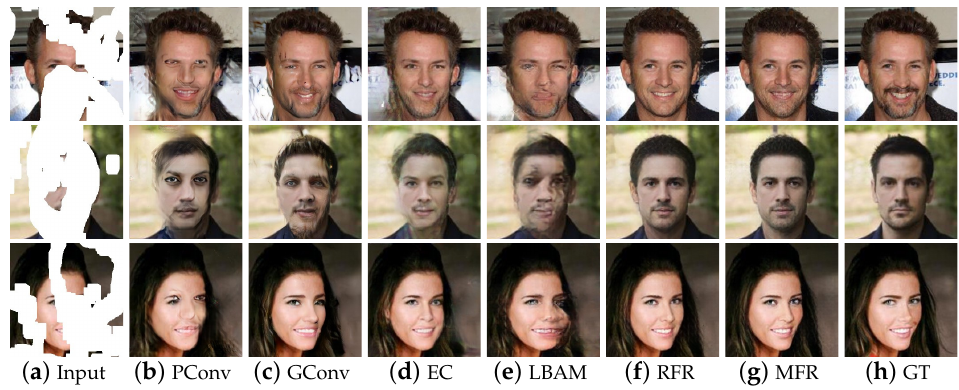
Figure 5. Qualitative comparison of CelebA.